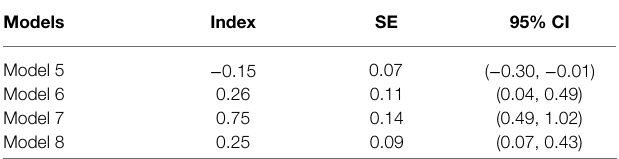
TABLE 4 | Indices of moderated mediation.